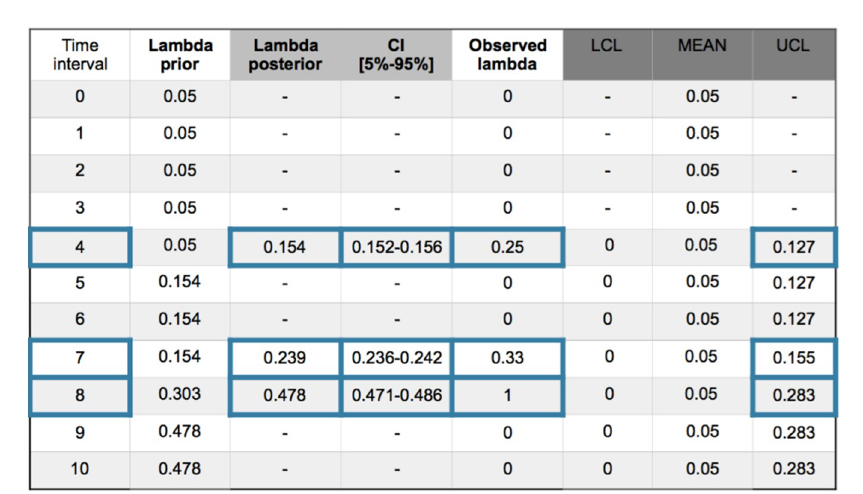
Figure 23. Poisson–normal model. Recurrent with mean prior method. Evolution of collected (ic’s) and safety barrier fails in 10 intervals. Confidence interval (CI) [5%–95%]. Out of limits framed blue.